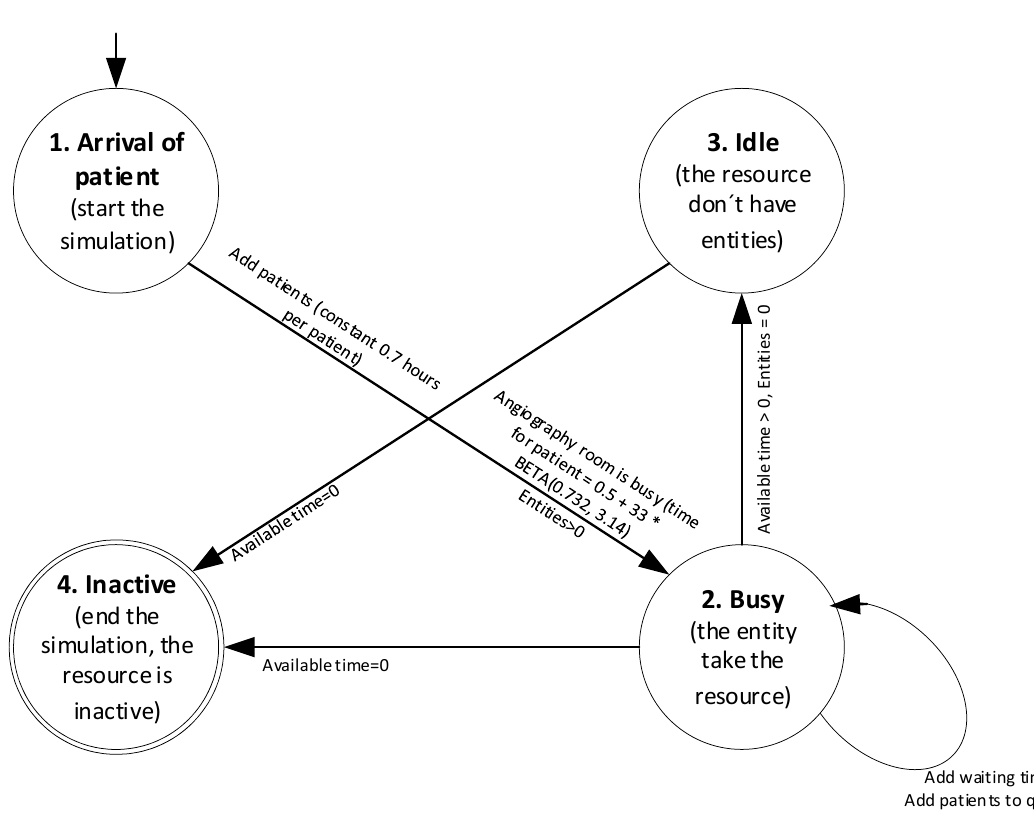
Figure 3. States transition diagram for the model DES.